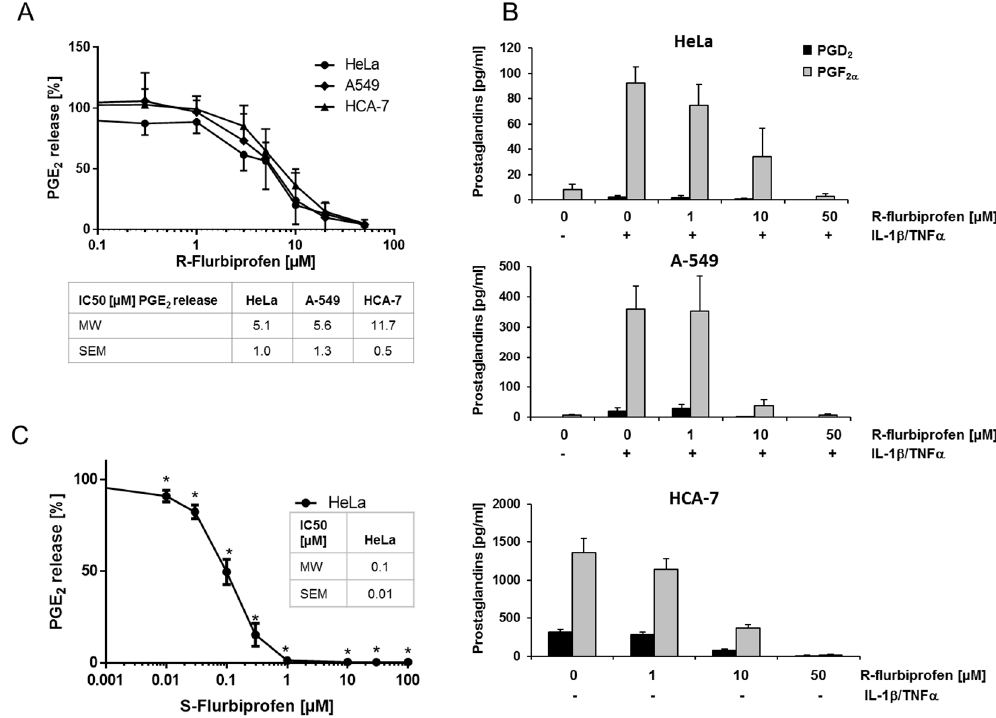
Figure 1. PGE 2 in cell supernatant of human cancer cell lines: Cells were treated either with 0.1% DMSO (control), S -flurbiprofen (0.01–10 µM) or R -flurbiprofen (0.03–50 µM) and, simultaneously, with IL-1 β (2 ng/mL) for stimulation of A-549 cells or IL-1 β (1 ng/mL) + TNF α (5 ng/mL) for stimulation of HeLa cells. HCA-7 cells were pre-incubated with medium containing either DMSO (0.1%) or flurbiprofen for 1 h and this medium was replaced with fresh medium and the same additions. ( A ) R -flurbiprofen inhibited PGE 2 production by all three cell lines at concentrations between 1 and 50 µM. Means ± S.E.M. of four independent experiments; ( B ) R -flurbiprofen also inhibited the release of PGD 2 and PGF 2 α from HeLa, A-549 and HCA-7 cells in a concentration-dependent manner. Means ± S.E.M. of three independent experiments; ( C ) S -flurbiprofen is 50-fold more potent than R -flurbiprofen in inhibiting PGE 2 production in HeLa cells with an IC 50 of about 100 nM. Means ± S.E.M. of three independent experiments. Significant p values are shown as: * p ≤ 0.05.